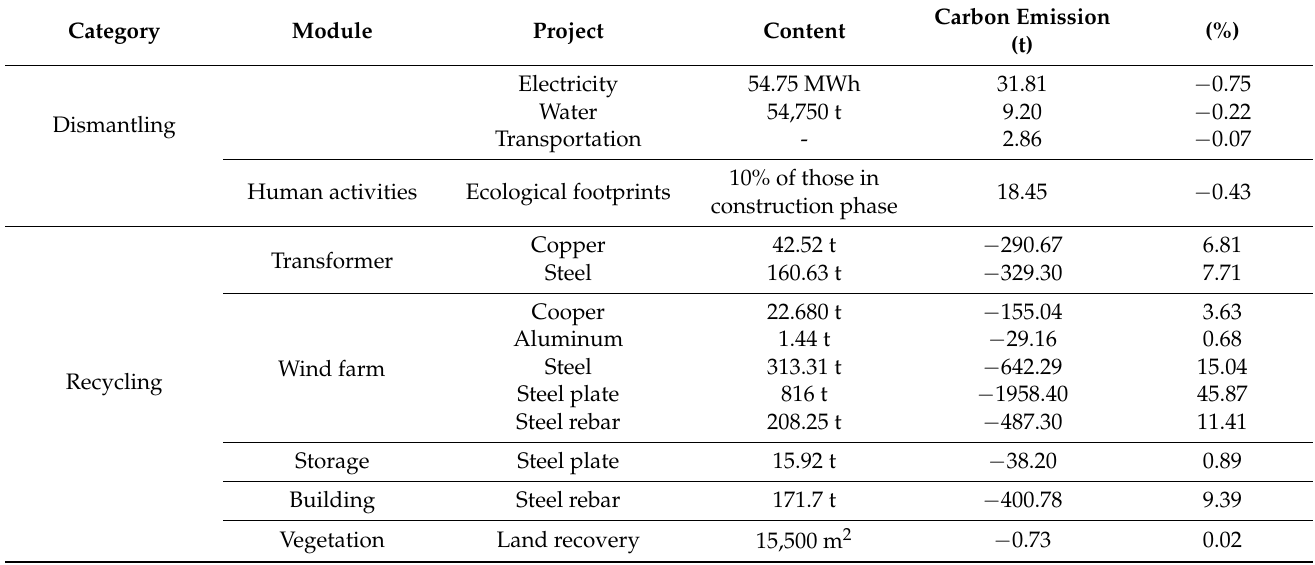
Table 10. Carbon emissions in the disposal and recycling